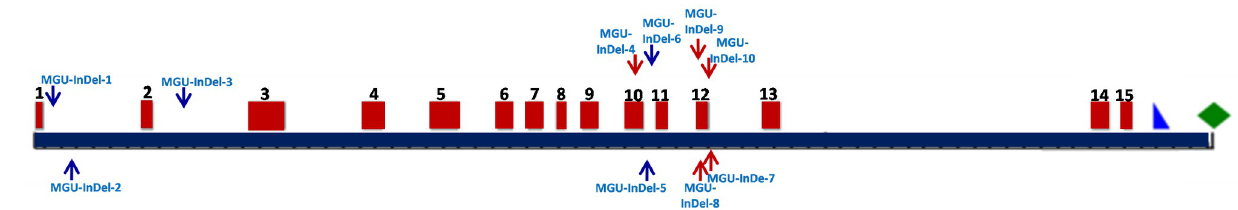
Fig 1. Pictorial representation of primer positions in Sh2 gene (Blue and red arrows represent positions at intron and exon, respectively; Grey boxes represent exons; blue triangle: Last exon; Green: PolyA tail).